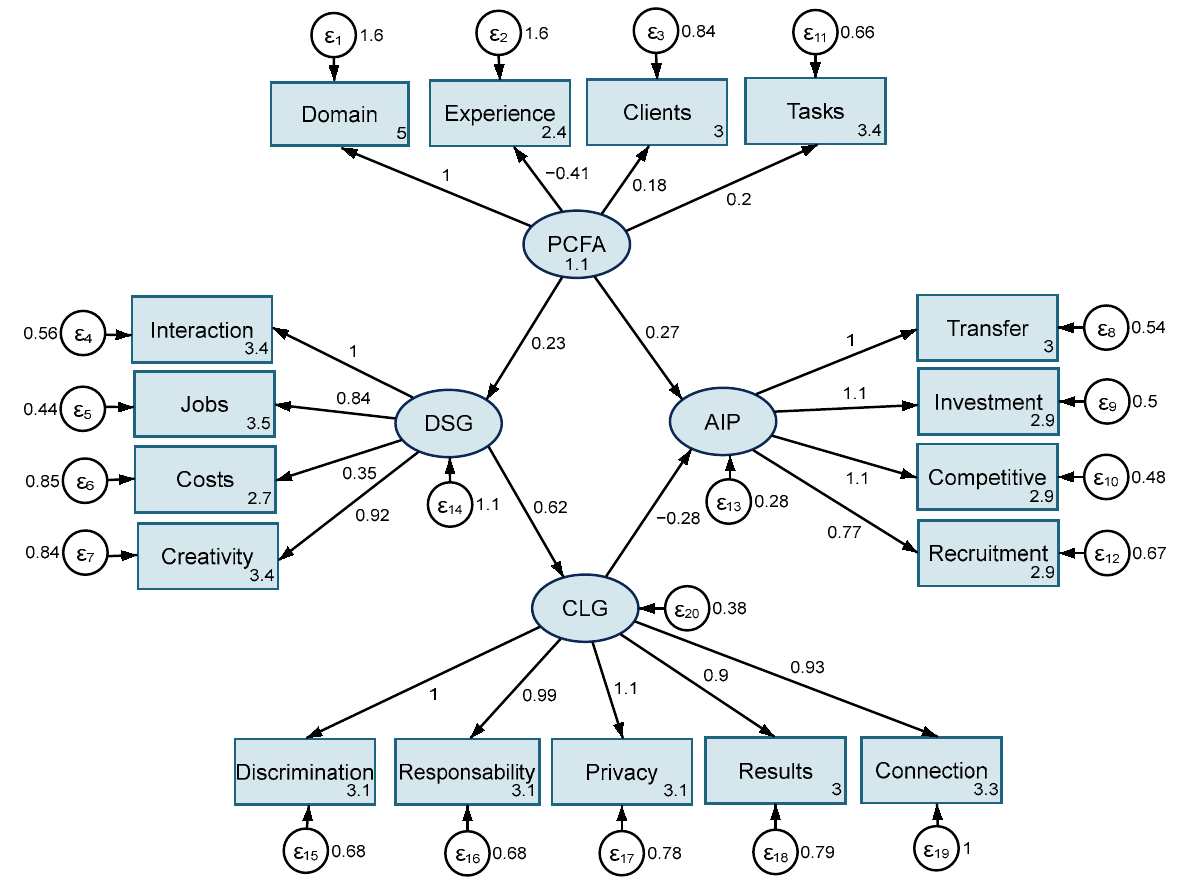
Figure 2. Results of the structural equation model (SEM). Source: Authors’ contribution in Stata 13.0.